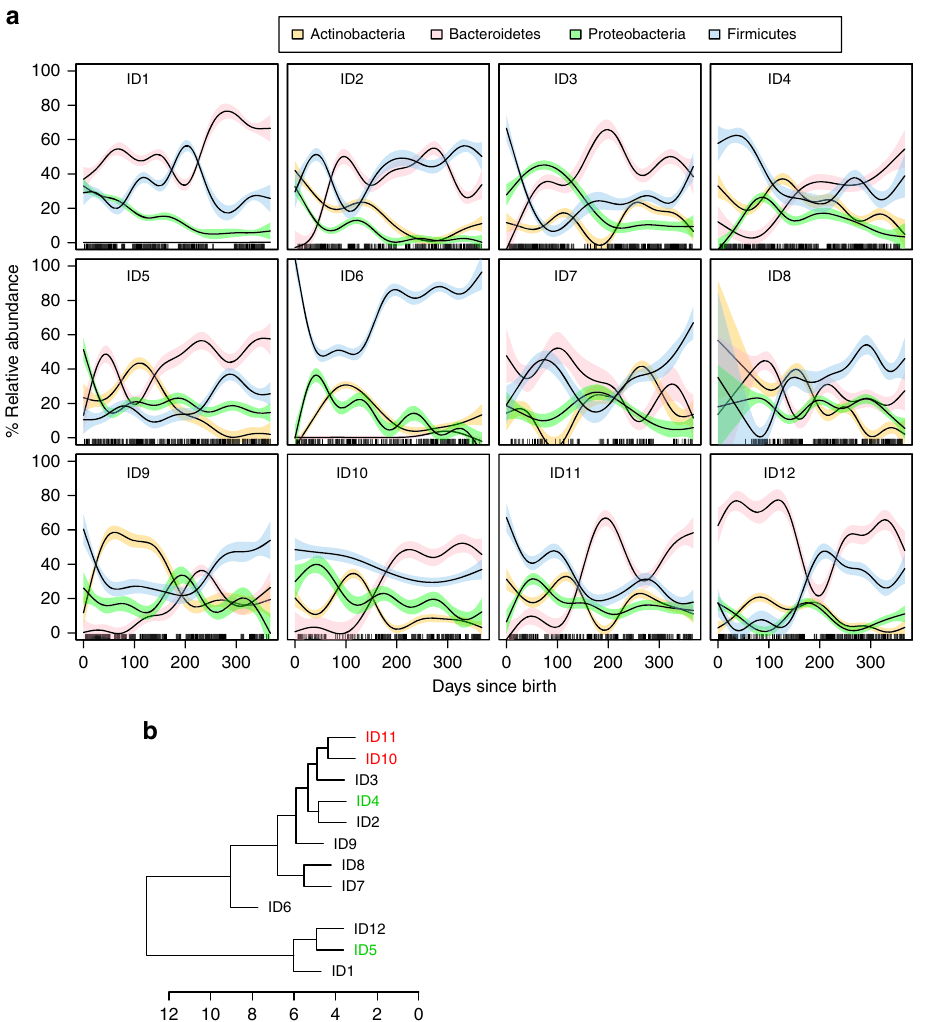
Fig. 3 Phylum level dynamics of the GI microbiota over the fi rst year of life in the 12 infants cluster on two main branches. a Relative abundances of the four main phyla in each infant. Lines are fi tted generalized additive models and colored bands are 95% con fi dence limits for smooth terms of the fi tted models (see color code). Rugs along the x -axis indicate days for which we had samples. b Hierarchical clustering based on mean dynamic time warp distances between the time series in a . The two twins are indicated in red, while the siblings born 16 months apart are indicated in green. The axis beneath the tree indicates number of distance units separating the